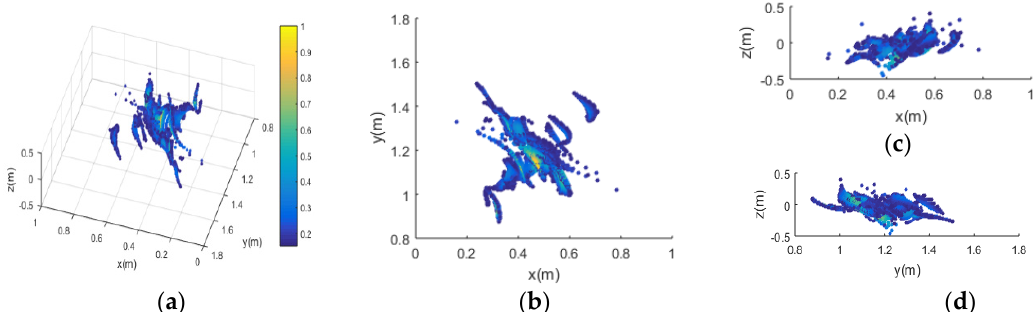
Figure 19. Three - dimensional imaging results with InPhaA removed and image distortion corrected: ( a ) 3D reconstruction; ( b ) projection on x - y plane; ( c ) projection on x - z plane; ( d ) projection on y - z plane.